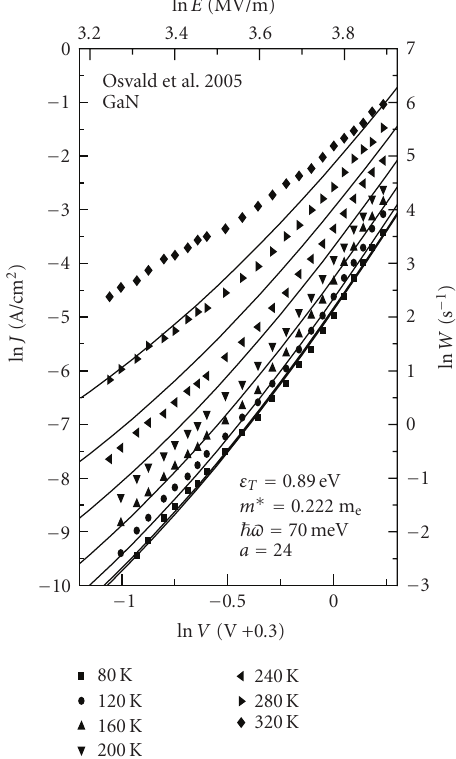
Figure 2: Comparison of I-V dependences for metal/n-GaN Schot- tky diode from Figure 2 [5] (symbols) with theoretical W ( E , T ) against E dependences (solid curves), computed using parameters: ε T = 0.89 eV, m ∗ = 0.222 m e , (cid:2) (cid:5) = 70meV, a = 2 . 4.